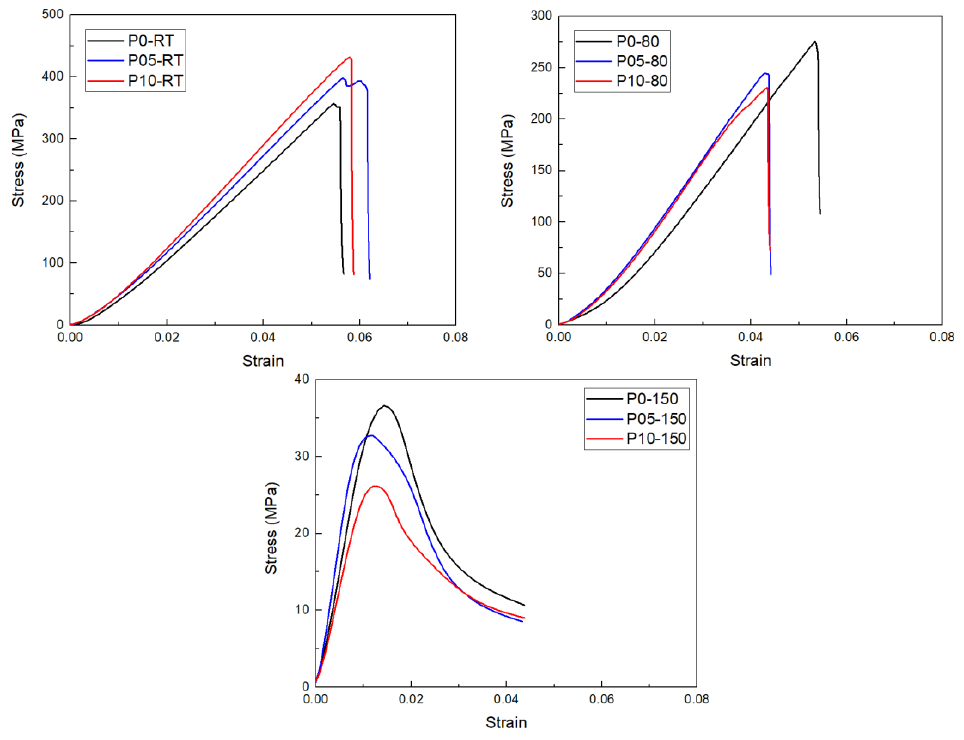
Figure 9. Stress-strain curves of PWLCs.